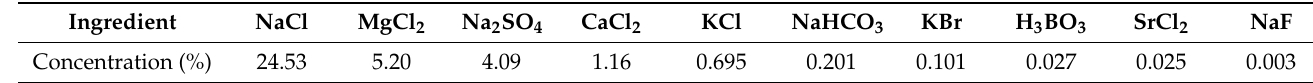
Table 2. Chemical composition ratio of artificial seawater.